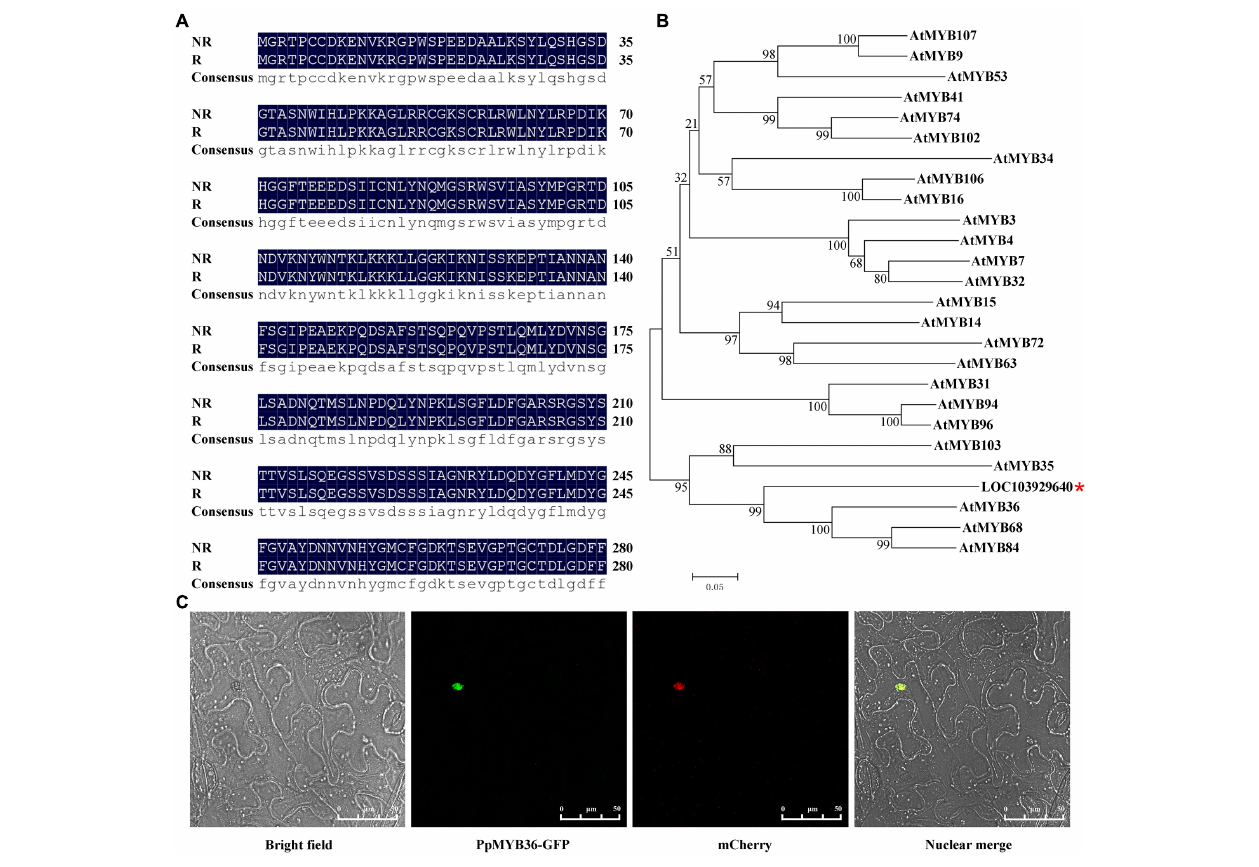
FIGURE 5 | Amino acid sequences, phylogenetic tree, and subcellular localization of PpMYB36. (A) Amino acid sequence alignment of the two PpMYB36 proteins from russet (R) and non-russet (NR) pears. (B) A phylogenetic tree showing the relationships between PpMYB36 from pear and 25 MYB protein sequences from Arabidopsis thaliana . Bootstrap values indicate the confidence of each branch. *indicated the position of PpMYB36. (C) Subcellular localization of the PpMYB36-GFP fusion driven by the CaMV35S promoter following transient expression in leaf cells of Nicotiana benthamiana .